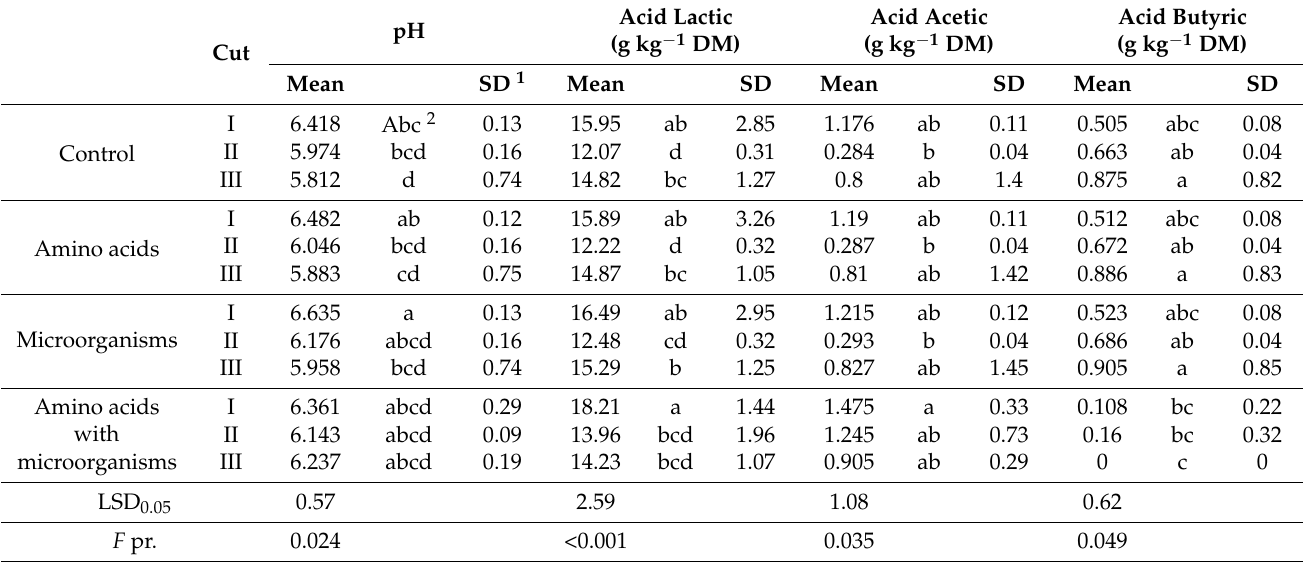
Table 3. Chemical compositions of the